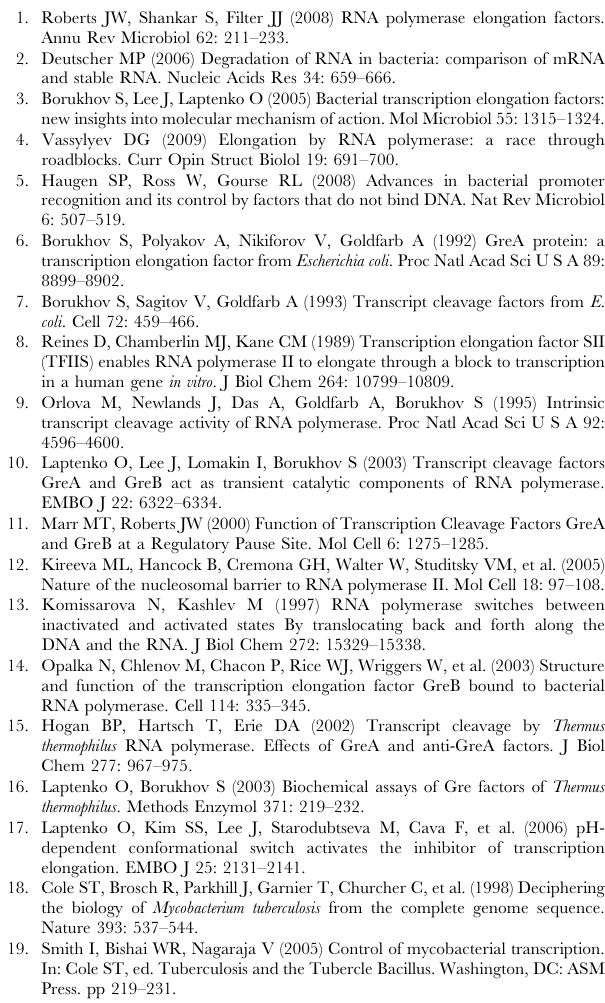
probed with the anti-Gre antibody to estimate the Gre protein level in cells at different growth phases. ( C ) Western blot analysis for Gre from cell lysate of M. smegmatis exposed to different stresses. Figure S7 Expression of Gre from pTrc gre construct in E. coli TK1021. ( A ) The gel shows expression of Mtb Gre from the pTrc gre construct, induced with 0.3 mM IPTG. ( B ) Transcript cleavage assays using Mtb Gre and E. coli GreA. Only Mtb Gre shows cleavage of mycobacterial RNAP elongation complex.